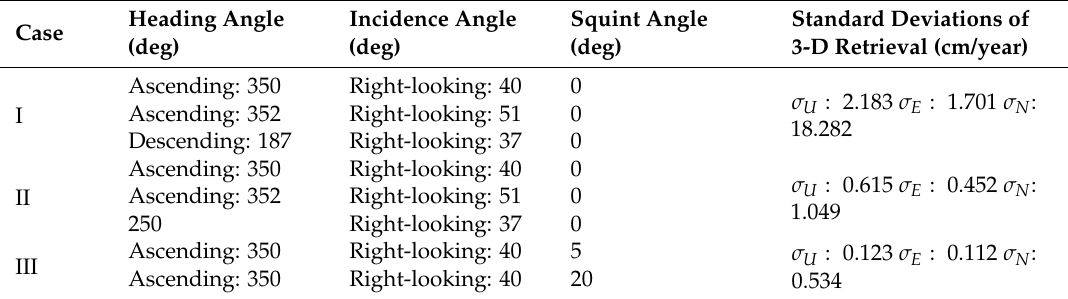
Table 1. Acquisition parameters of each scenarios and the performance of 3-D